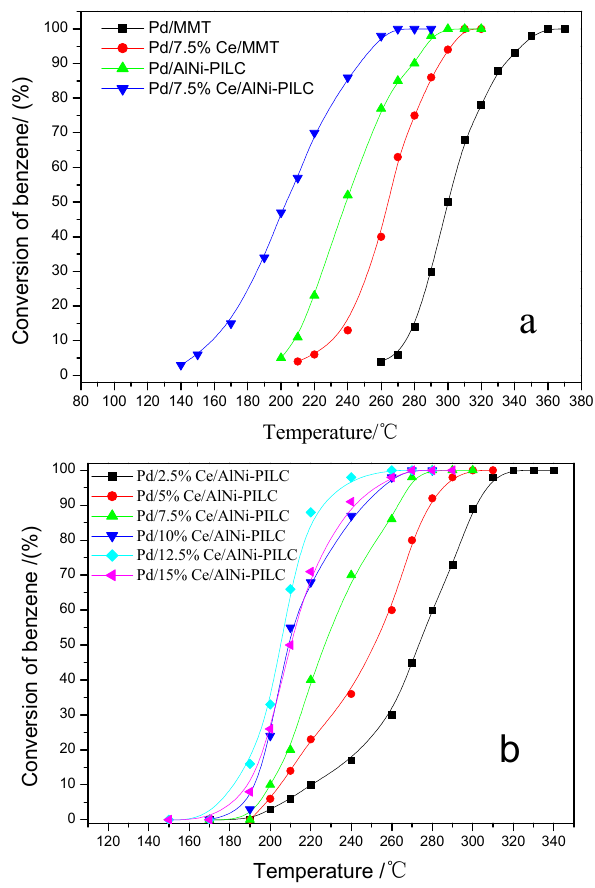
Figure 1. ( a ) Influence of the addition of Ce into Pd/MMT and Pd/AlNi-PILC for benzene complete oxidation; ( b ) influence of the content of Ce into Pd/AlNi-PILC for benzene complete oxidation. Benzene concentration: 1000 ppm; gas hourly space velocity (GHSV): 20,000 h − 1 ; Catalyst amount: 350 mg.